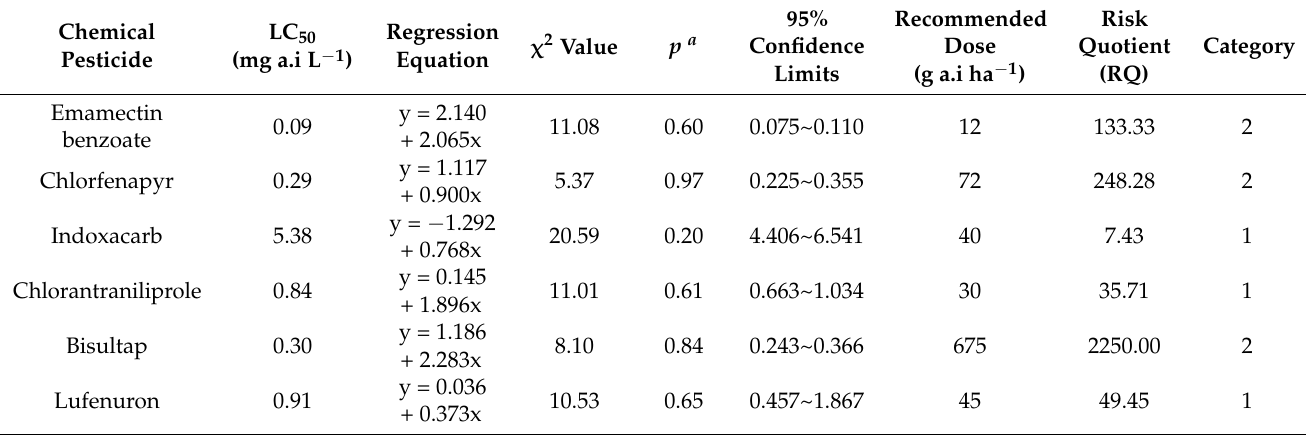
Table 1. Risk assessment of emamectin benzoate, chlorfenapyr, indoxacarb, chlorantraniliprole, bisultap, and lufenuron on Tetrastichus howardi